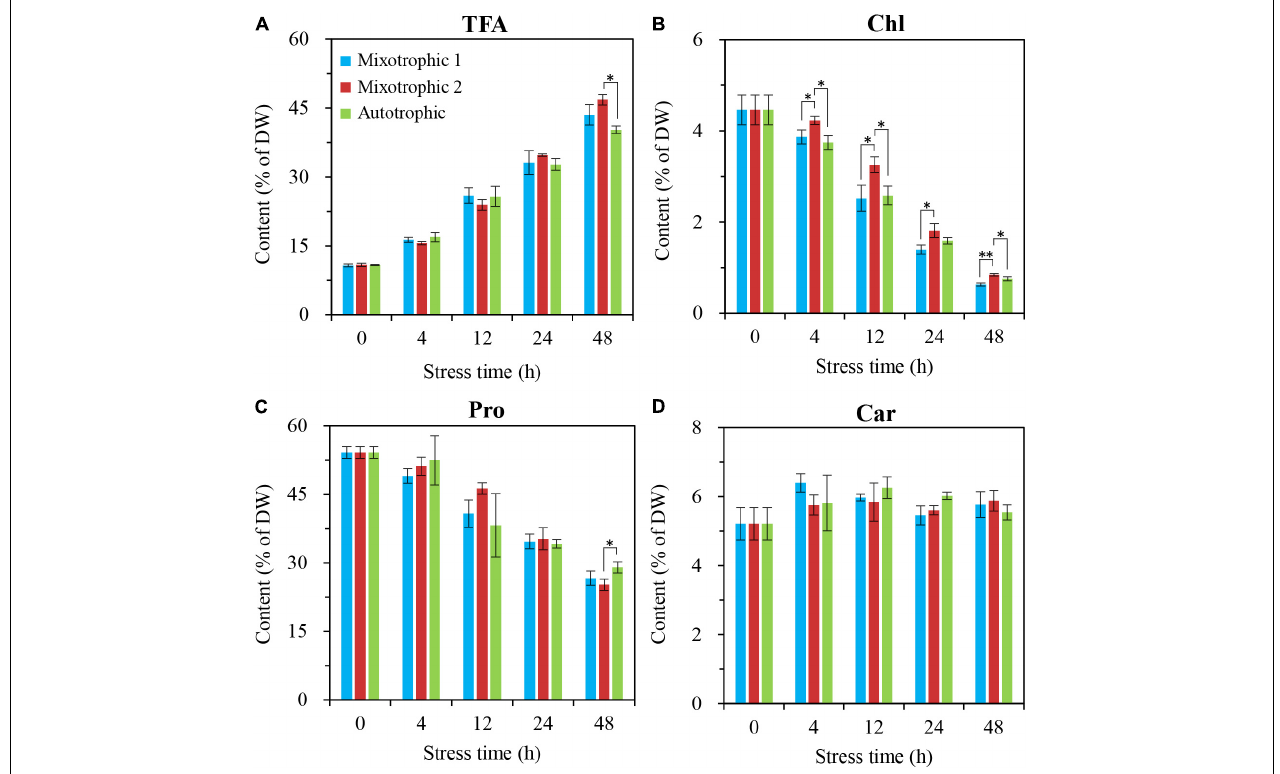
FIGURE 3 | Time course of changes in amounts of total fatty acids (A) , chlorophyll (B) , protein (C) , and carbohydrate (D) in C. reinhardtii BAFJ5 under three carbon supply regimes over 48 h of HL-N. The carbon supply regimes for mixotrophic 1, mixotrophic 2, and autotrophic were 17 mM acetate and 2% CO 2 (v/v), 17 mM acetate and ambient 0.04% CO 2 (v/v), and 2% CO 2 (v/v), respectively. Values are the means of three independent replicates ± SD ( n = 3). TFAs, total fatty acids; Chl, chlorophyll; Pro, protein; Car, carbohydrate; DW, cellular dry weight; ∗ p < 0.05; ∗∗ p < 0.01.